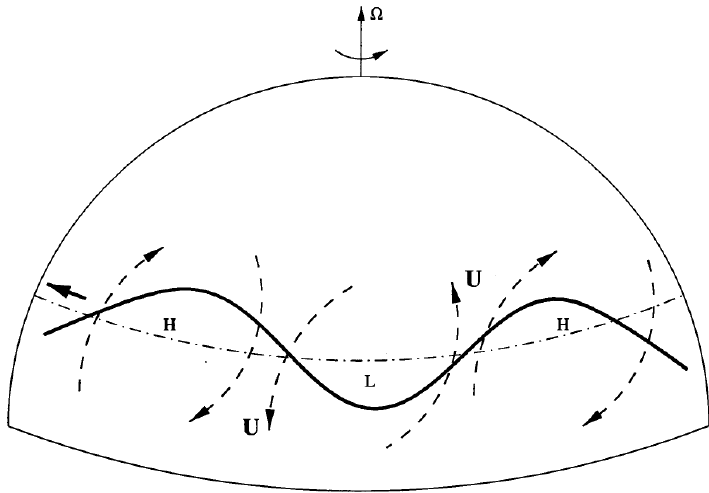
Fig. 1. Visualization of a planetary wave in the Northern Hemisphere (from Shalimov et al., 1999, based on Holton, 1982).